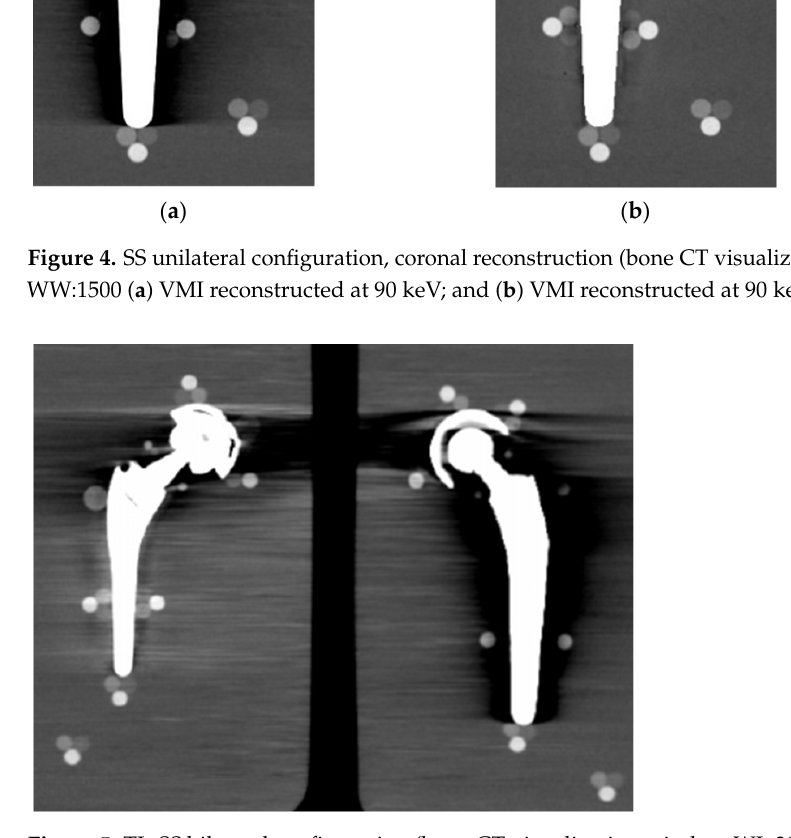
Figure 5. TI+SS bilateral configuration (bone CT visualization window WL:300, WW:1500). TI right prosthesis coupled with a left SS prosthesis. VMI reconstructed at 130 keV.